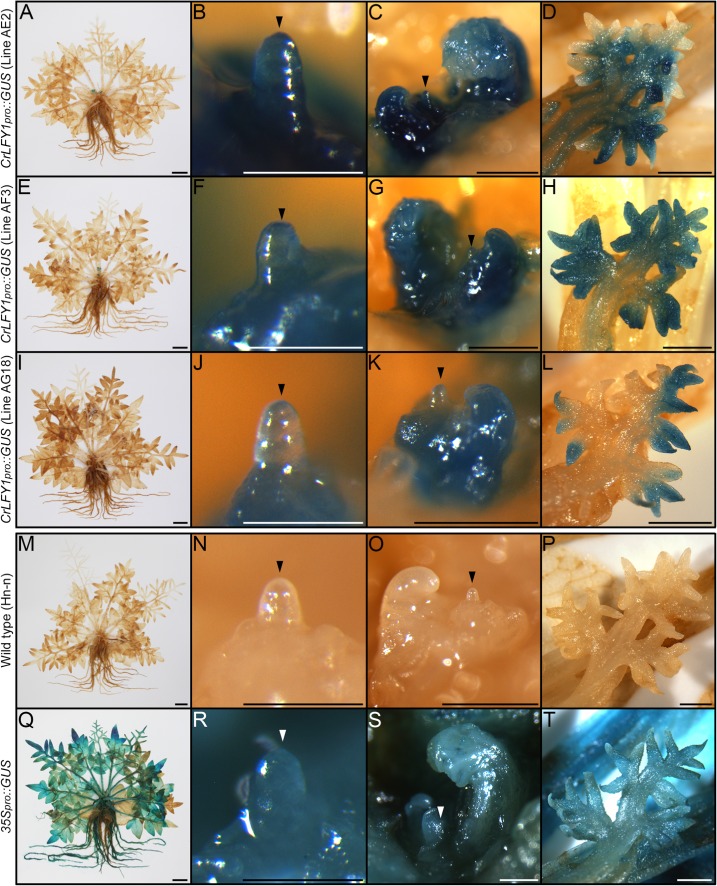
CrLFY1pro::GUS expression patterns are similar in Ceratopteris shoots before and after reproductive phase change.GUS activity detected as blue staining in sporophytes producing fronds with spore-bearing morphology (narrowing and elongation of pinnae) from three independent CrLFY1pro::GUS transgenic reporter lines (A–L); 110–124 DAF), negative wild-type controls (M–P); 113 DAF) and positive 35Spro::GUS controls (Q–T); 110 DAF). Staining patterns were consistent between the three independent CrLFY1pro::GUS transgenic lines (A, E, I), and were similar to those seen at 60 DAF (Figure 4C, (H,M). GUS activity was observed throughout the shoot apex (B, F, J) and in recently-emerged frond primordia (C, G, K). Activity persisted later in frond development, becoming restricted to developing pinnae (D, H, L). GUS staining was lost from fronds prior to maturity (A, E, I). No endogenous GUS activity was detected in wild-type controls (M–P) whereas activity was detected throughout all non-senescent tissues in the 35Spro::GUS line (Q–T).